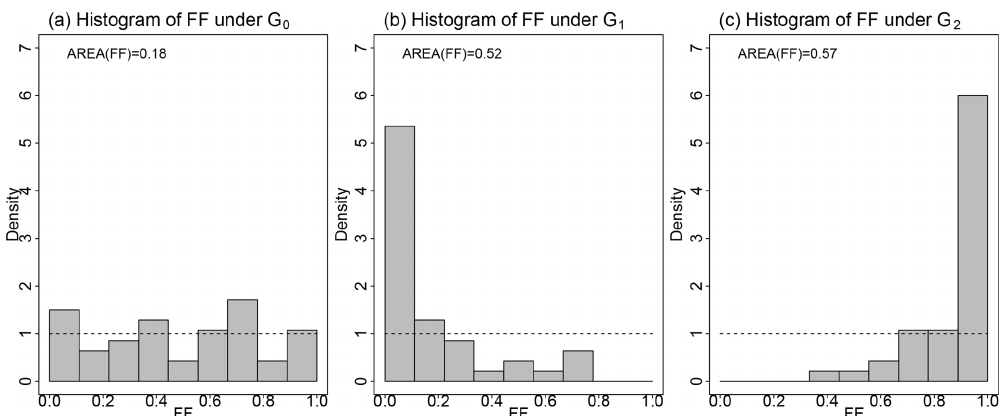
Figure 3. Illustration of the FF score when the true CDF G 0 is extended exponential with λ = 20 and κ = 0 . 3. The CDF G 1 underesti- mates G 0 ( λ = 25) while G 2 overestimates G 0 ( λ = 15). (a) Histogram of { G 0 (m) } n where m are 42 realizations of G n (b) Histogram of { G 1 (m) } n . (c) Histogram of { G 2 (m) } n . The horizontal dashed lines show the uniform density on (0,